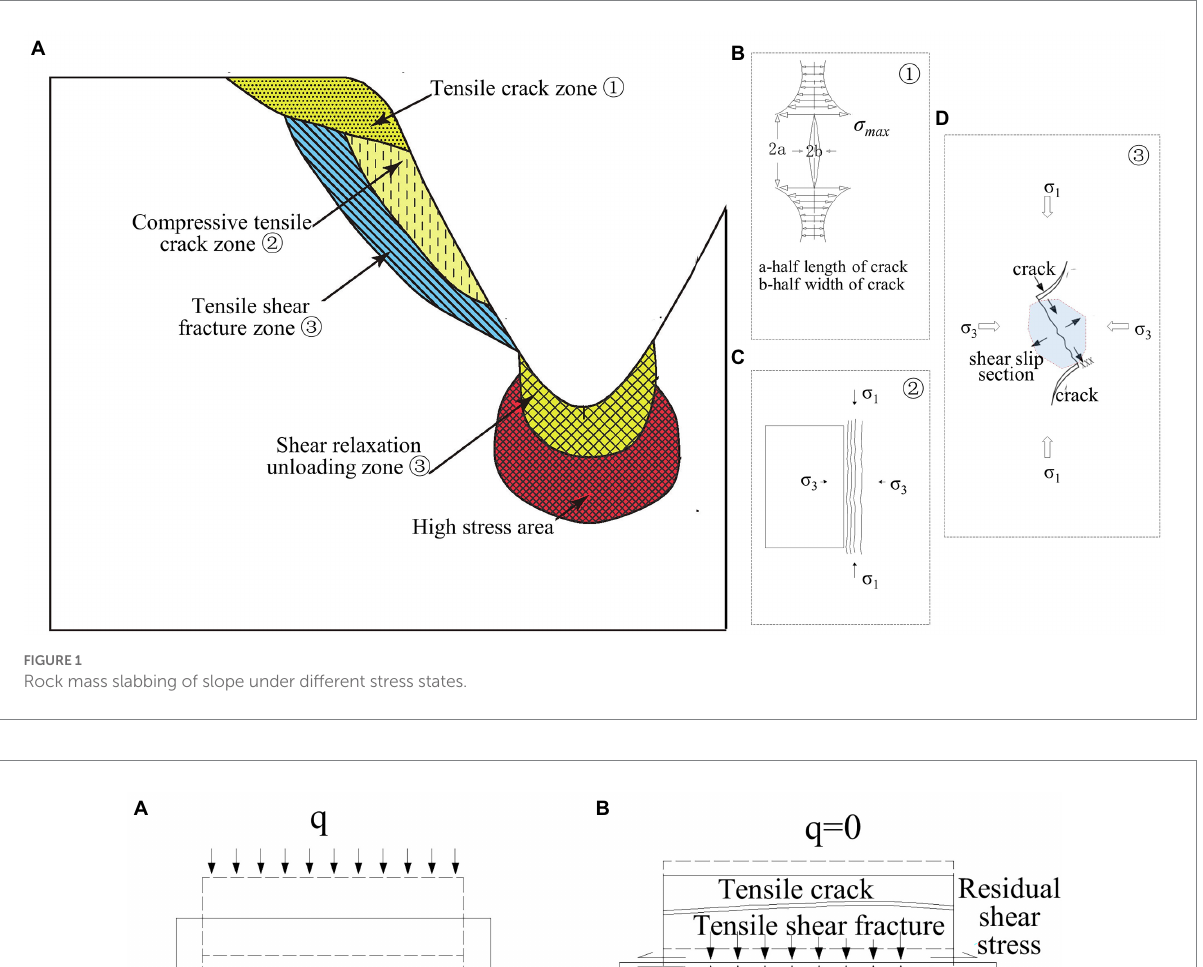
FIGURE 2 Differential resilience of rock strength differences. (A) loading and (B)